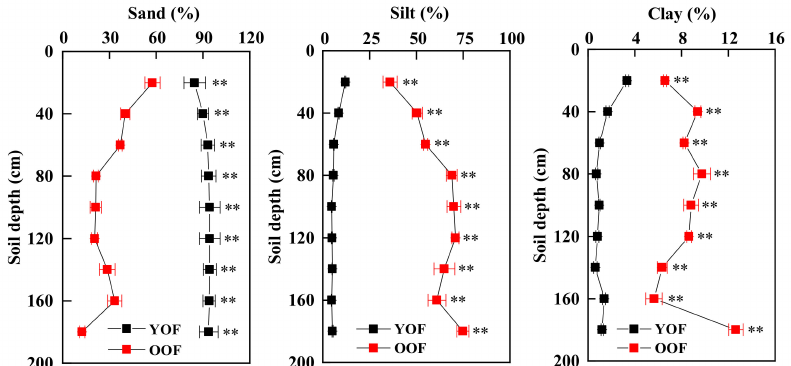
Figure 3. Soil particle size distribution in the 0–200 cm soil profile in the old oasis field (OOF) and young oasis field (YOF). Error bars represent standard deviation. ** represent p < 0.01 between the YOF and the OOF at the same depth,